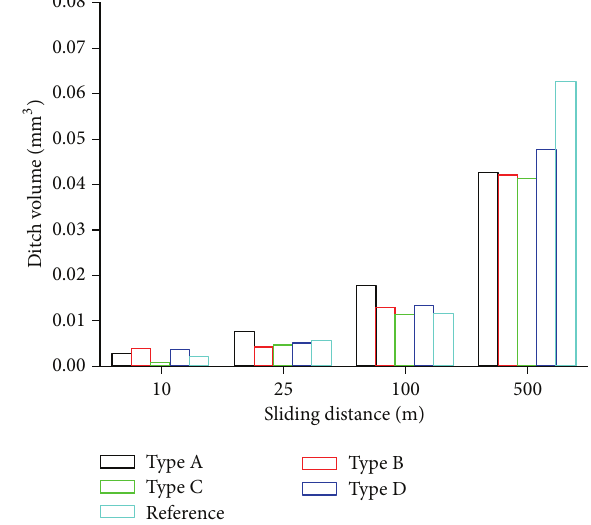
Figure 11: Wear tests: volume of abraded